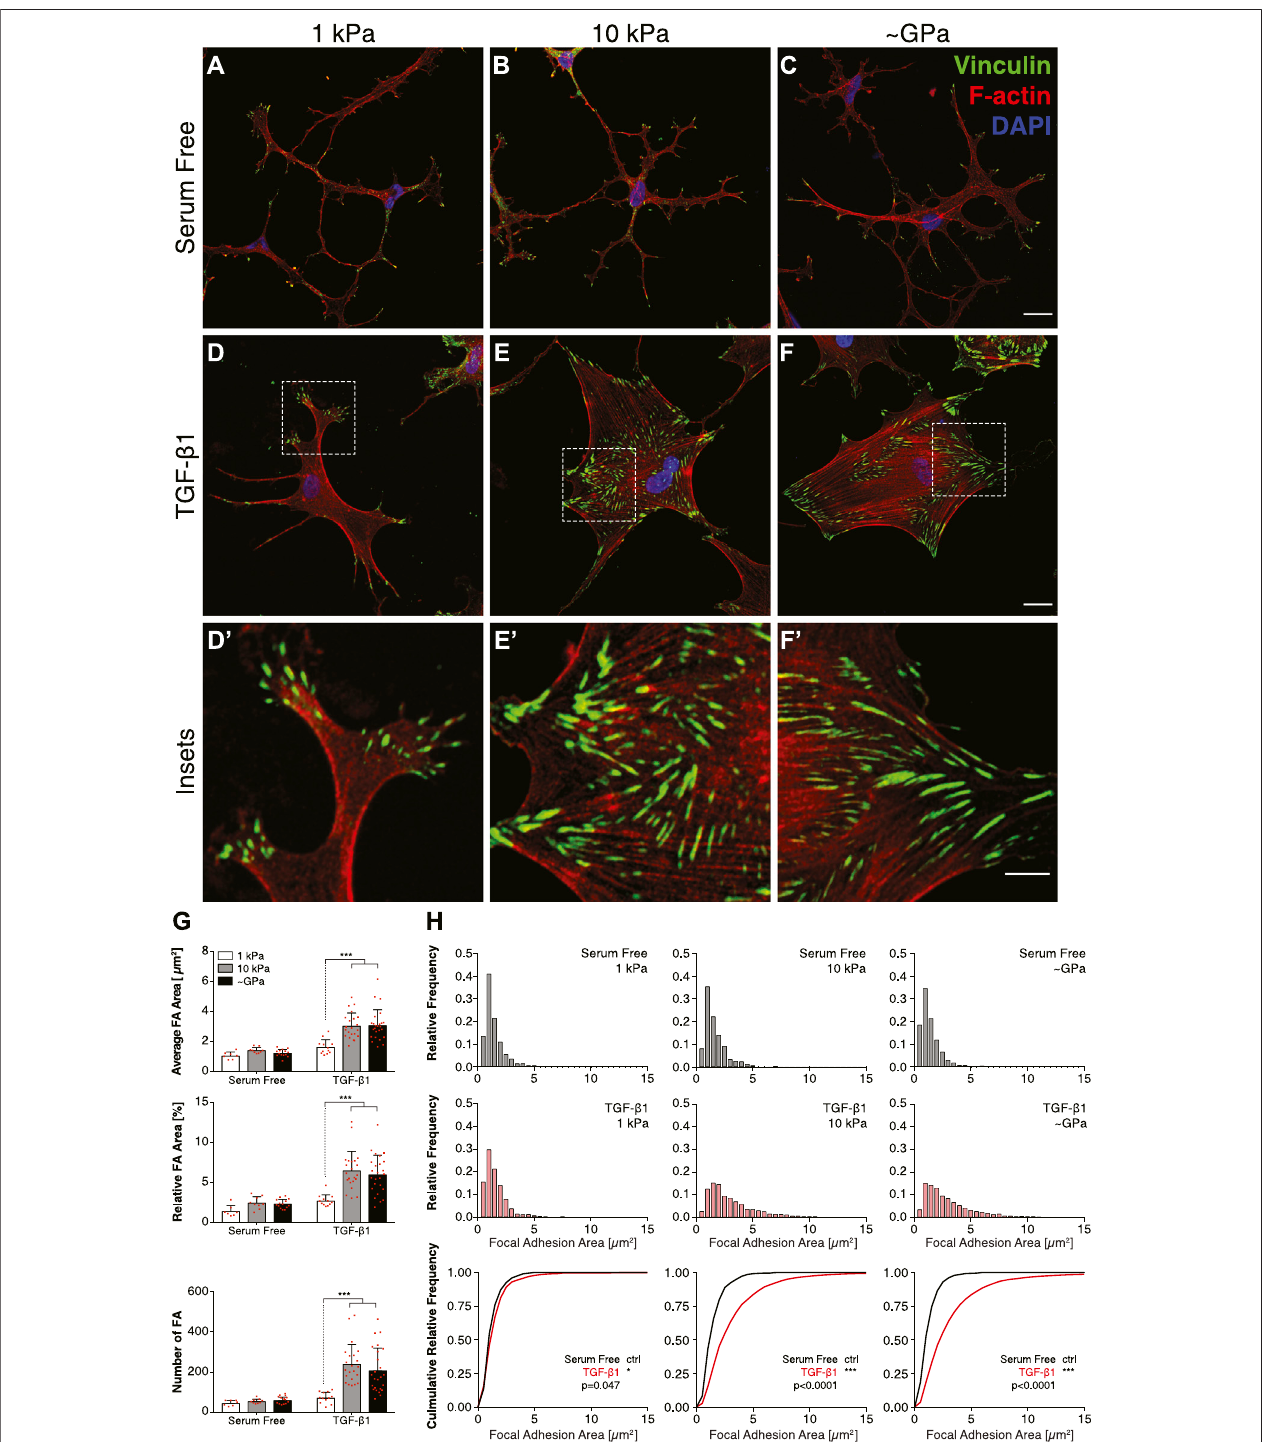
FIGURE 2 | Substratum stiffness modulates the size and subcellular localization of focal adhesions in TGF- β 1-treated keratocytes. (A – F) Characteristic confocal fl uorescence images of cells cultured on either functionalized 1 kPa (A,D) or 10 kPa (B,E) PA substrata, or collagen-coated glass (C,F) coverslips. Prior to fi xation, cells were cultured in either serum-free conditions (A – C) or in medium containing exogenous TGF- β 1 (D – F) for 5 days. Keratocytes were stained for vinculin immuno fl uorescence(green),aswellasF-actin (red) and DAPI(blue). Dashed whiteboxesindicate insets (D 9 – F 9 ) .Scalebars,25 μ m.(Inset scalebars,10 μ m). (G) Quanti fi cation of the average area, relative area, and number of focal adhesions (FA) per cell. Error bars represent mean ± s.d. for n = 10 substrates from 5 experimental replicates.Statisticalcomparisonsweremadeusingatwo-wayANOVAfollowedbyaTukeypost-hoctest.(***, p < 0.001) (H) RelativefrequencyhistogramsofFAareain either serum-free conditions (top row; grey bars) or medium containing TGF- β 1 (middle row; red bars). These plots were used to create cumulative frequency plots (bottom row), which were compared statistically using a Kolmogorov-Smirnov test.